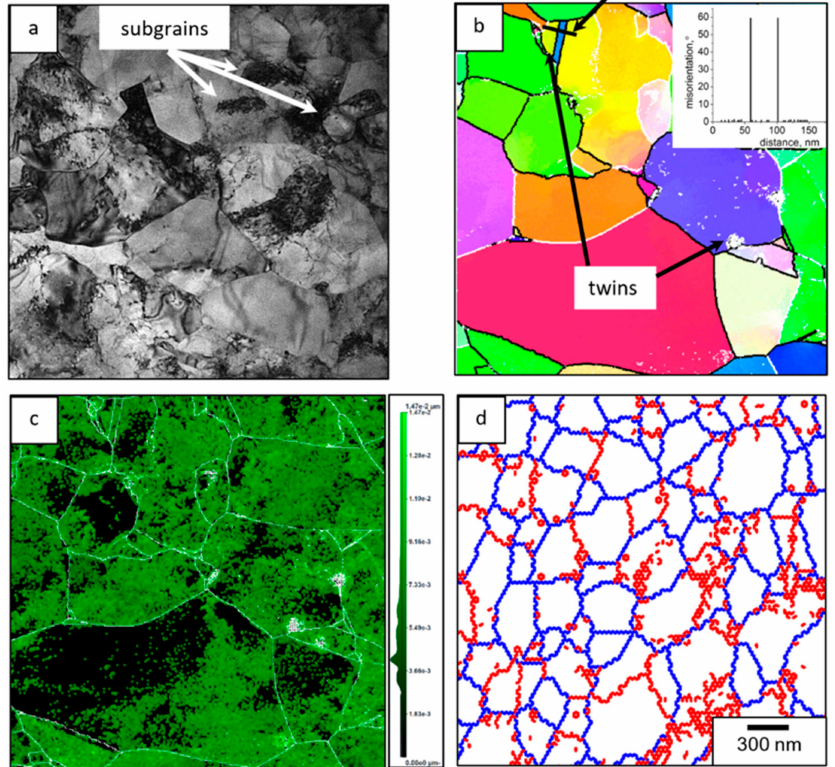
Figure 6. Microstructure of the HPTE Cu in the mid-radius area of the longitudinal section; all the images are at the same scale. ( a ) TEM BF image; ( b ) ACOM TEM OIM map in which LABs (3 ◦ < Θ < 15 ◦ are highlighted with white lines) and HABs ( Θ > 15 ◦ ) are highlighted with black lines; ( c ) GND distribution map from ACOM TEM (all GBs are marked with white lines; and ( d ) EBSD OIM GBs network (LABs marked with red lines, HABs marked with blue